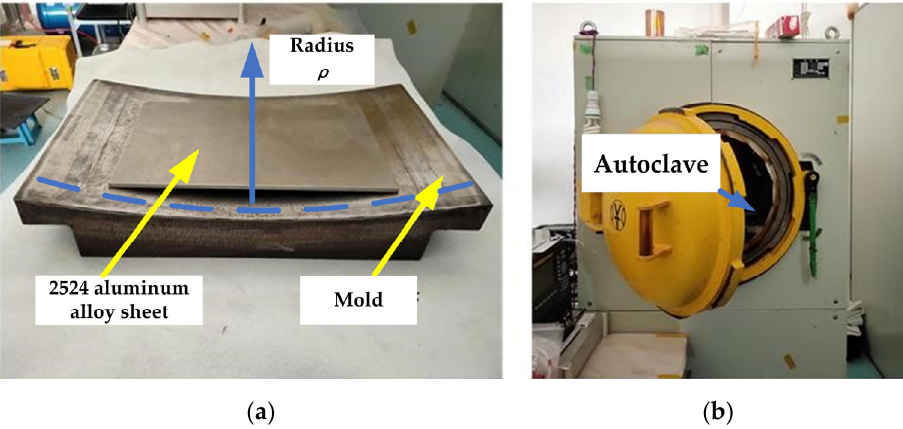
Figure 1. Creep-aging forming mold and tooling: ( a ) mold and sheet; ( b ) autoclave.